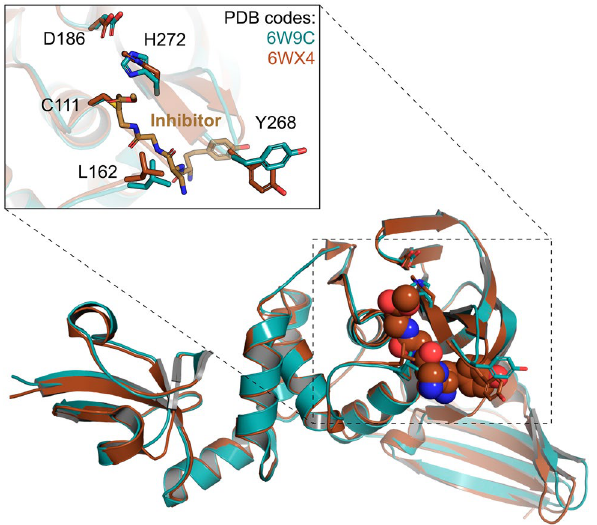
Figure 1. Conformations of the Nsp3-PLpro domain provided at the DockThor-VS web server as representative structures of the protein flexibility. The apo structure is coloured blue (PDB code 6W9C) and the structure initially complexed with a covalently bound peptide inhibitor is coloured brown (PDB code 6WX4 29